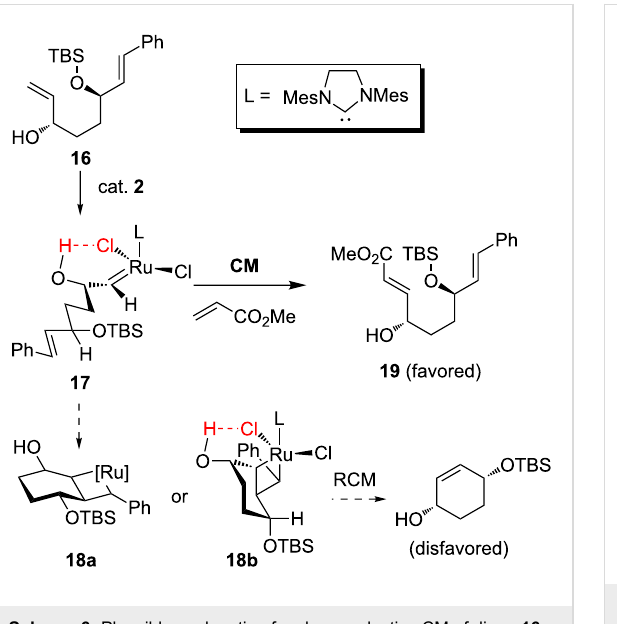
Scheme 6: Plausible explanation for chemoselective CM of diene 16